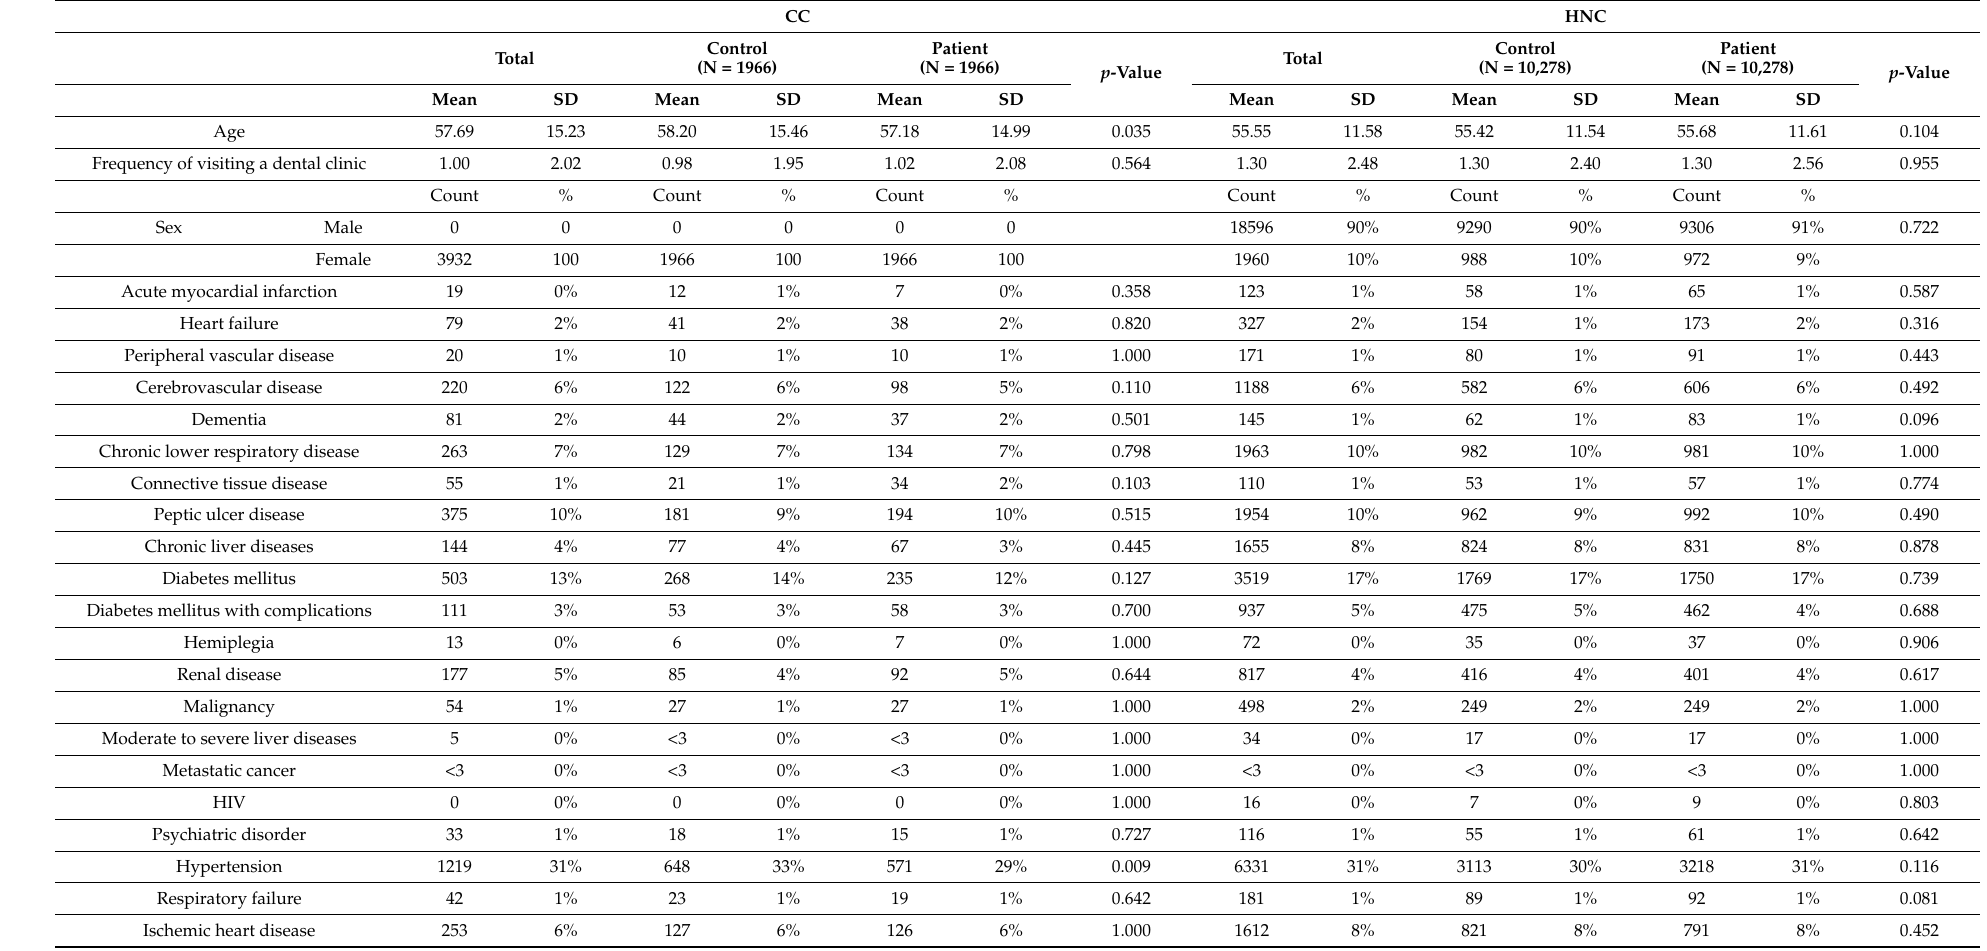
Table 1. Demographics and comorbidities of patients with newly diagnosed CC and HNC in 2014–2015 and in matched non-cancer